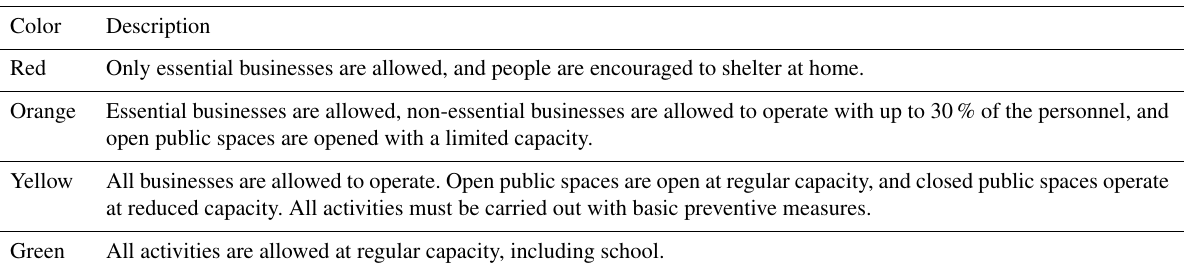
Table 2. Categories of the epidemiological risk stoplight during the “new normality” in Mexico (Secretaría de Salud,